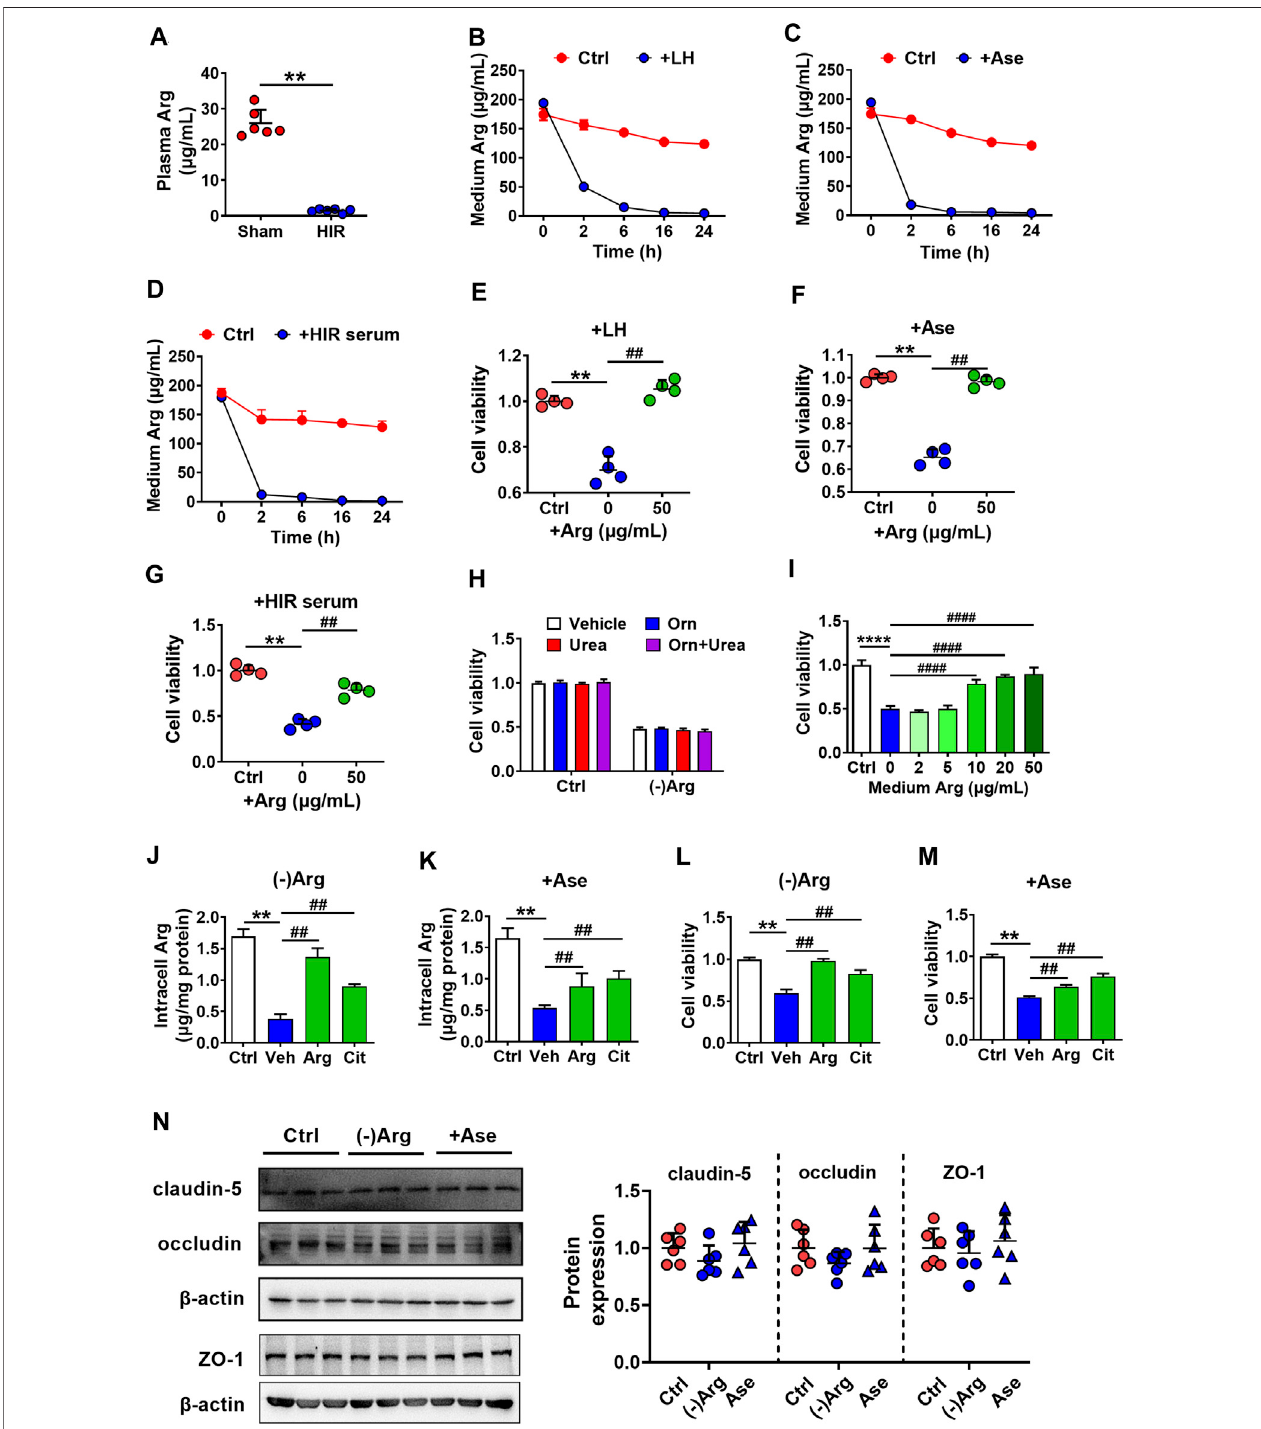
FIGURE 4 | Arginase damaged hCMEC/D3 cells via depriving Arg. (A) Plasma arginine (Arg) level in hepatic ischemia-reperfusion (HIR) rats (1 h ischemia and 4 h reperfusion) and sham-operated(Sham) rats( n (cid:2) 4). (B) Arg levels inculture medium following treatment withratliver homogenate (LH)(200 μ g/ml), (C) arginase (20 μ g/ ml) (Ase), or (D) 10%serumof HIR rats ( n (cid:2) 3). (E) Effect of Arg supplement on damaged viability of hCMEC/D3 cells caused byLH, (F) Ase, or (G) HIR rat serum ( n (cid:2) 4). (H) Effect of Arg-free culture ((-)Arg), adding ornithine (Orn) (1 mM), urea (1 mM) or combination of Orn with urea (Orn + Urea) on hCMEC/D3 cell viability ( n (cid:2) 4). (I) Effect of addition of increasing Arg on hCMEC/D3 cells damage caused by (-)Arg ( n (cid:2) 4). (J) Effect of adding Arg or citrulline (Cit) (200 μ g/ml) on the decrease in intracellular Arg level caused by (-)Arg or (K) Ase compared with adding vehicle (Veh) ( n (cid:2) 3). (L) Effect of adding Arg or Cit (200 μ g/ml) on damaged cell viability of hCMEC/D3 caused by (-)Arg or (M) Ase compared with adding vehicle (Veh) ( n (cid:2) 4). (N) Western blot of tight junctions in hCMEC/D3 cells treated with (-)Arg or Ase ( n (cid:2) 6).Datawereexpressedasmean ± SD.** p < 0.01versuscontrol(Ctrl)cellsorShamrats; ## p < 0.01versuscellstreatedwithLH,Ase,andHIRratserumor(-)Arg;1-way ANOVA followed by Dunnett ’ s post hoc test or unpaired t -test in panel (A) . Frontiers in Pharmacology |